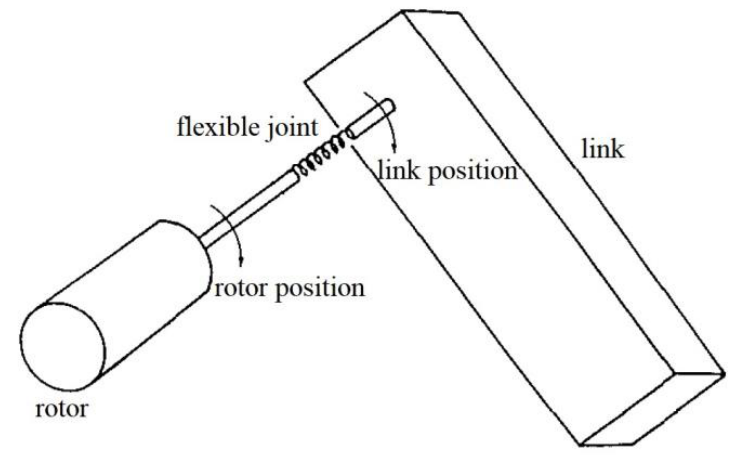
Figure 3. Scheme of the single-link manipulator.